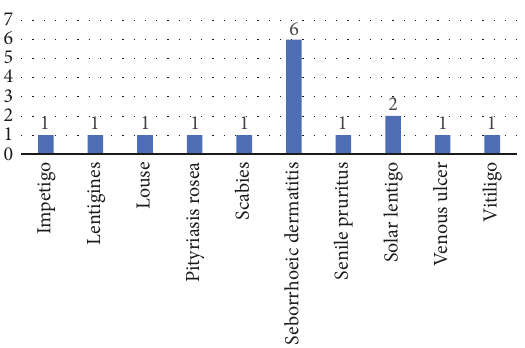
Figure 4: Diagnoses of the consultations rated as not accurate.